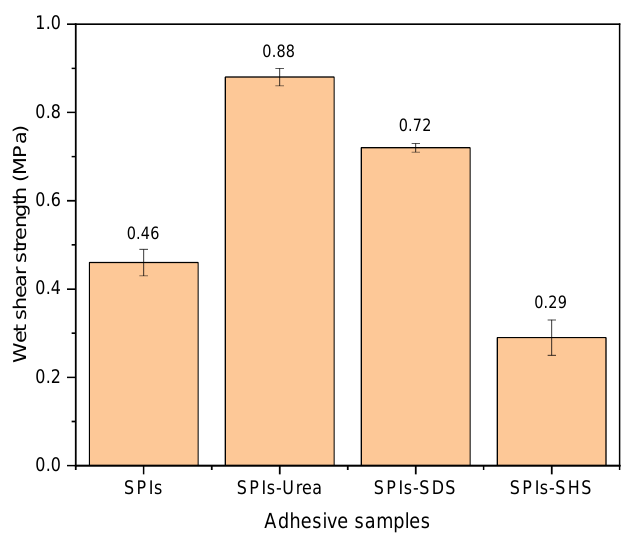
Figure 6. The wet shear strengths of plywood bonded by modified SPI adhesive.